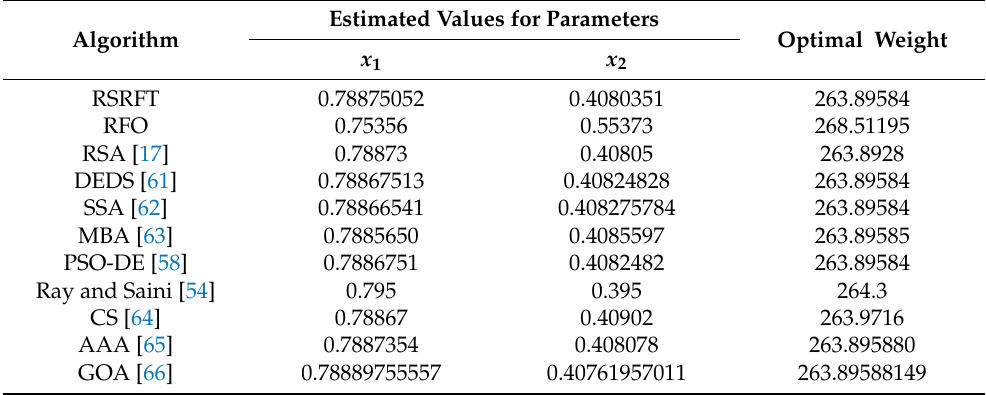
Table 4. The value of the estimated parameters using RSRFT to solve the 3-bar truss design problem.